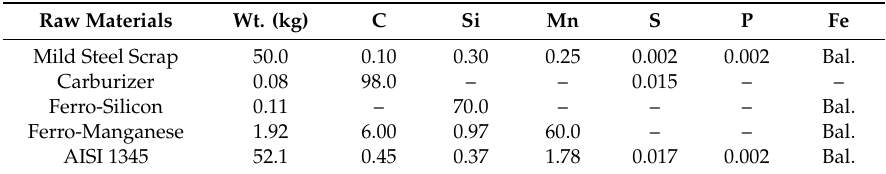
Table 1. Weights and chemical compositions (wt. %) of raw materials and produced AISI 1345 steel.